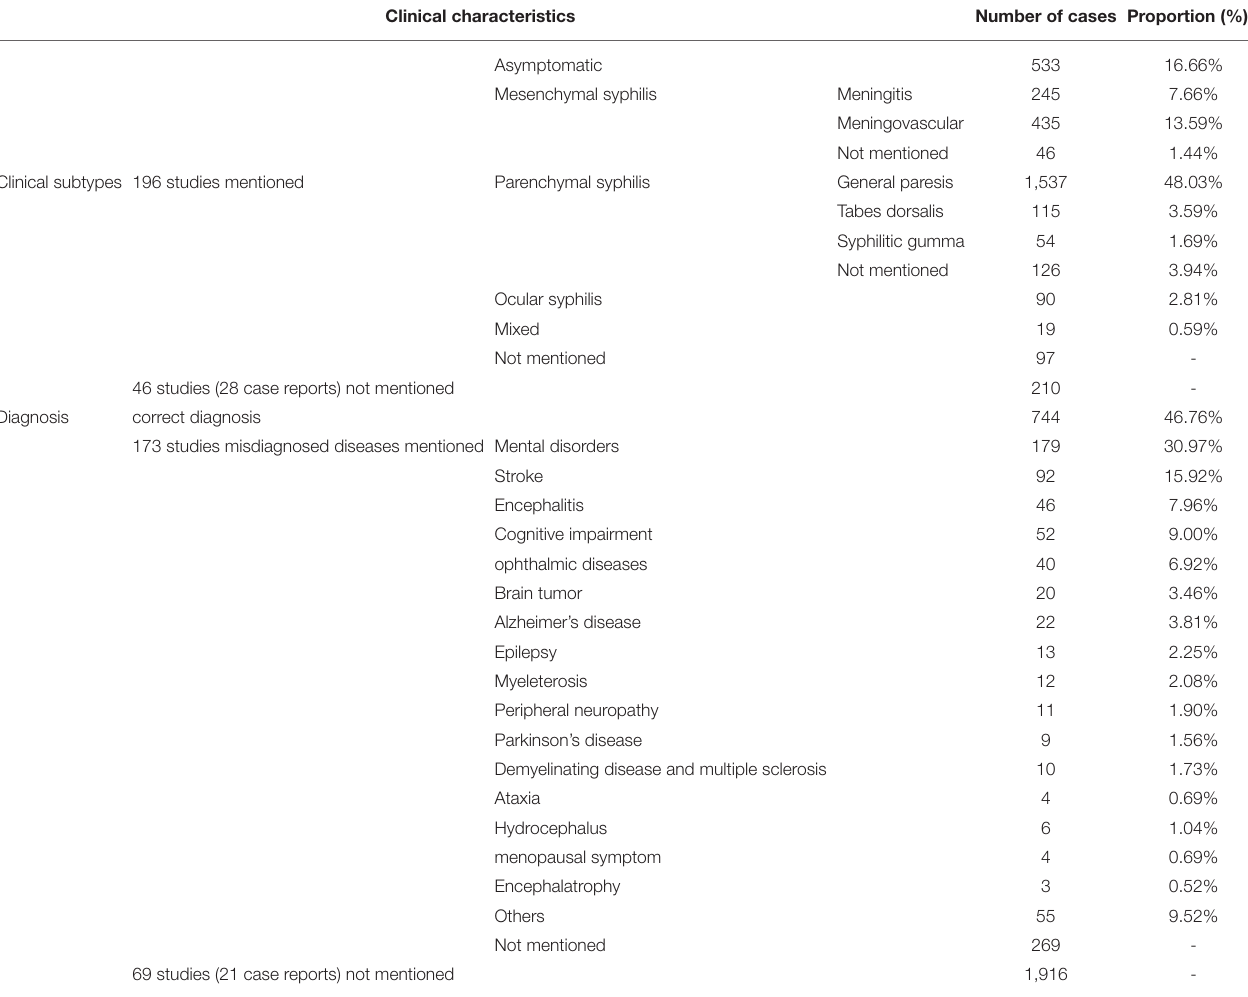
TABLE 1 | Clinical characteristics of neurosyphilis cases from 149 case reports and 93 retrospective case